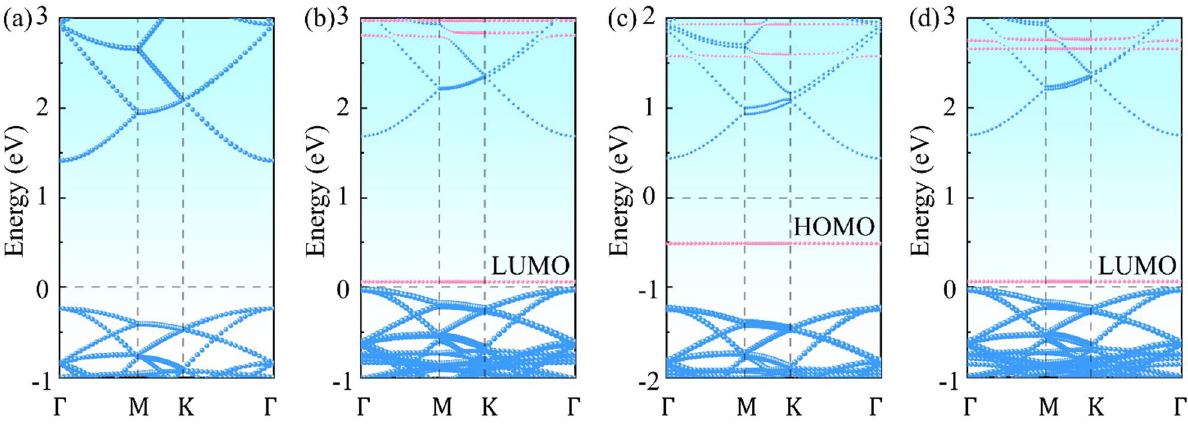
Figure 4. The work function of g−ZnO adsorption by organic molecules.